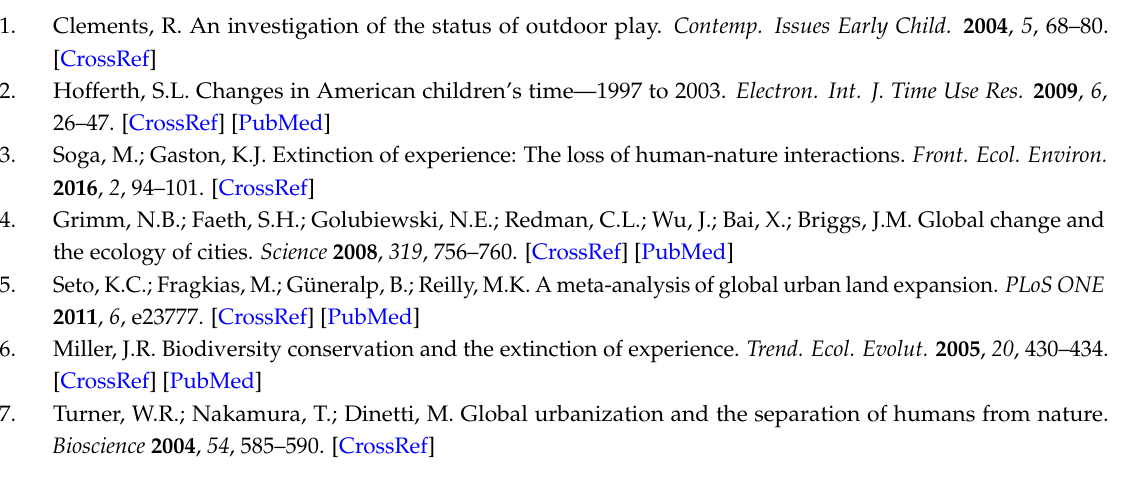
Figure S1: Land use map of the region around the study school (black square). In the middle of the map is the Tama River, the biggest river in Tokyo. Data from the Ministry of Land Infrastructure and Transport (http://www.mlit.go.jp/crd/daisei_ryokuhi_index.html), Figure S2: Ward’s dendrogram of a hierarchical cluster analysis conducted on 16 animal species, Table S1: Summary of Tukey’s HSD test (see Figure 2 in the main text), Table S2: Unstandardized and standardized parameter estimates for mediated relationships in the model (see Figures 3 and 5 in the main